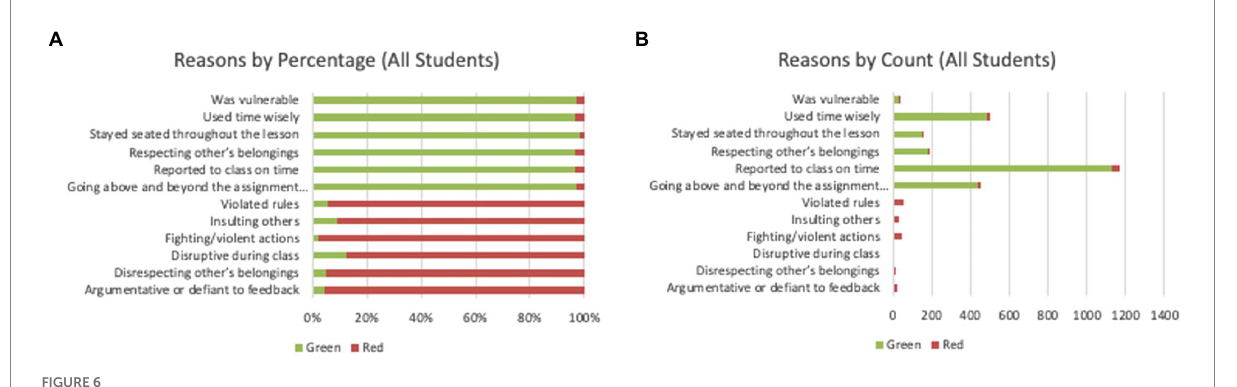
FIGURE 6 Reported reasons comparison between S LR (green) and C HR (red) labeled